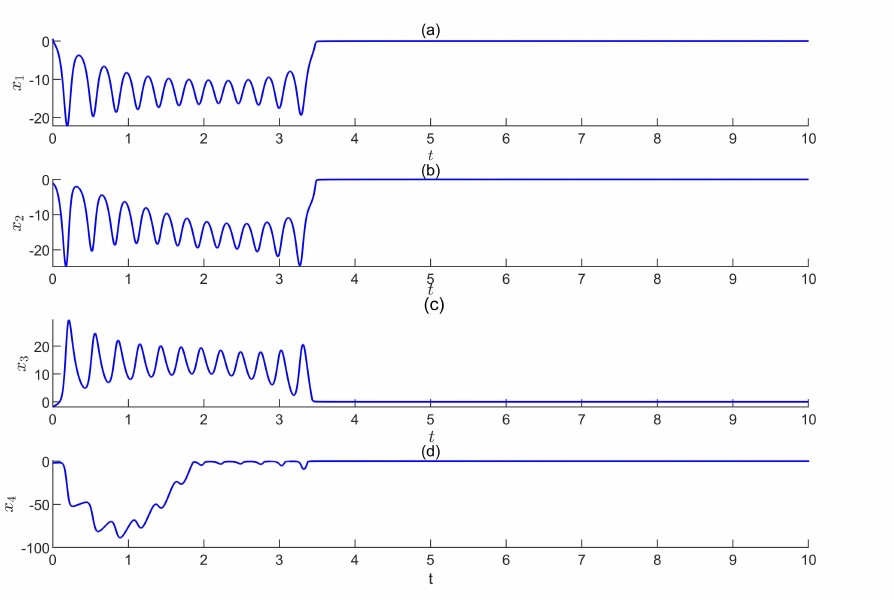
Figure 5. The state trajectories of the system (26) under the controller in [53]: ( a ) the x 1 − t space; ( b ) the x 2 − t space; ( c ) the x 3 − t space; ( d ) the x 4 − t